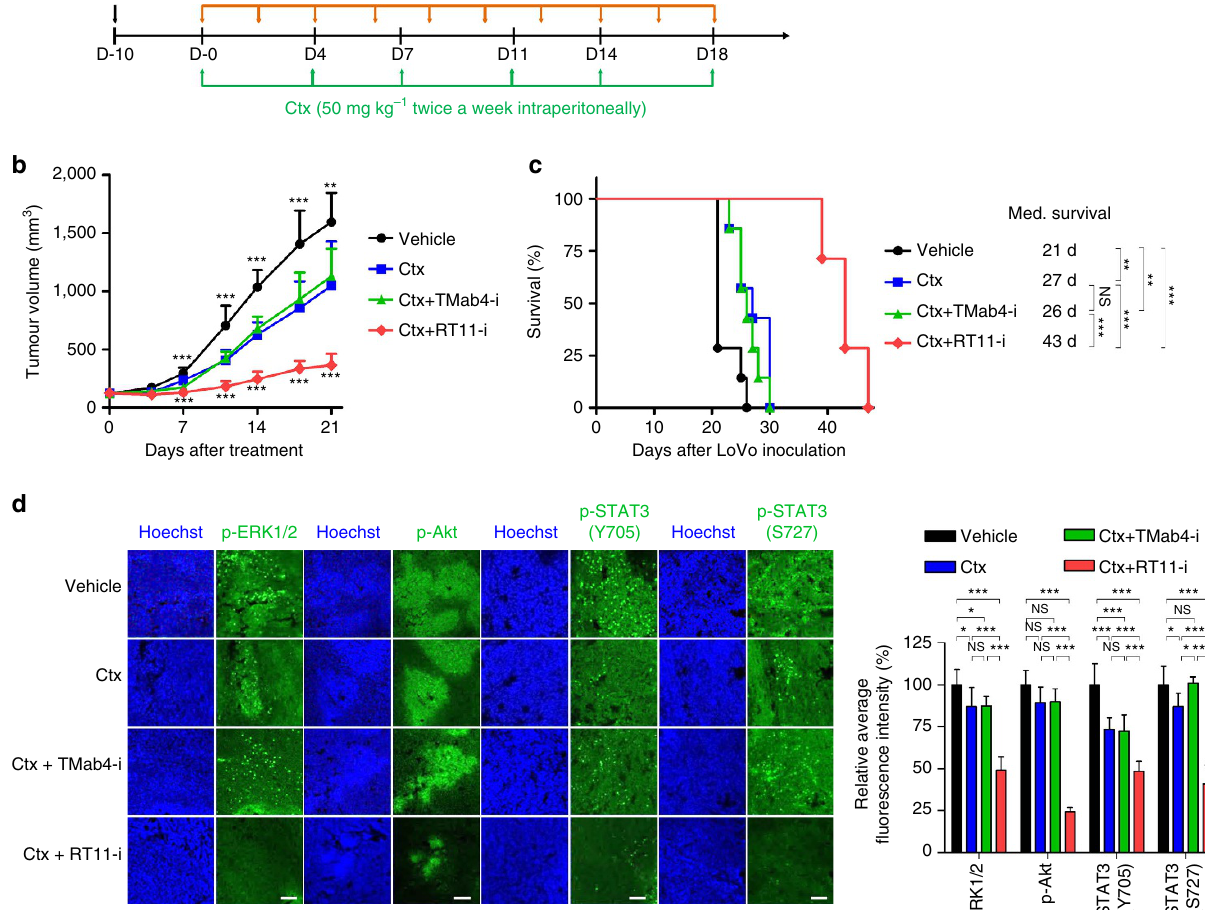
Figure 7 | Co-treatment of RT11-i overcomes cetuximab resistance in KRas mutant colorectal LoVo tumours in mice. ( a ) Outline of the RT11-i, TMab4-i, and/or cetuximab treatment regimen. ( b ) Tumour growth was analysed by measuring the tumour volume during treatment with vehicle, cetuximab (Ctx), Ctx plus TMab4-i or Ctx plus RT11-i in Lovo xenograft mice. Error bars, ± s.d. ( n ¼ 8 per group). Statistical analysis was performed using a one-way analysis of variance followed by the Newman-Keuls post-test. *** P o 0.001 versus Ctx alone. ( c ) Kaplan–Meier survival curves with median survival time listed for LoVo xenograft mice for the vehicle, Ctx, Ctx þ TMab4-i and Ctx þ RT11-i treatment groups ( n ¼ 8 per group). ** P o 0.01, *** P o 0.001 by Gehan-Breslow- Wilcoxon test for significance. Animals were killed when tumours reached B 1,000mm 3 in size. ( d ) Immunohistochemical analysis showing the levels of p-ERK1/2, p-Akt, p-STAT3 (Y705) and p-STAT3 (S727) in LoVo tumour tissues excised from mice following the treatment described in b . Nuclei were counterstained with Hoechst 33342 (blue). Scale bar, 100 m m. Images are representative of at least two independent experiments. The right panel shows the percent relative fluorescence intensity compared to that of the vehicle-treated control group. Error bars, ± s.d. of five random fields for each tumour (two tumours per group). Statistical analysis was performed using a one-way analysis of variance followed by the Newman–Keuls post-test. * P o 0.05, ** P o 0.01, *** P o 0.001; NS, not